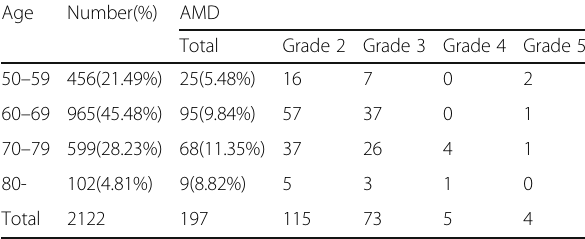
Table 1 The age and grade distribution of AMD